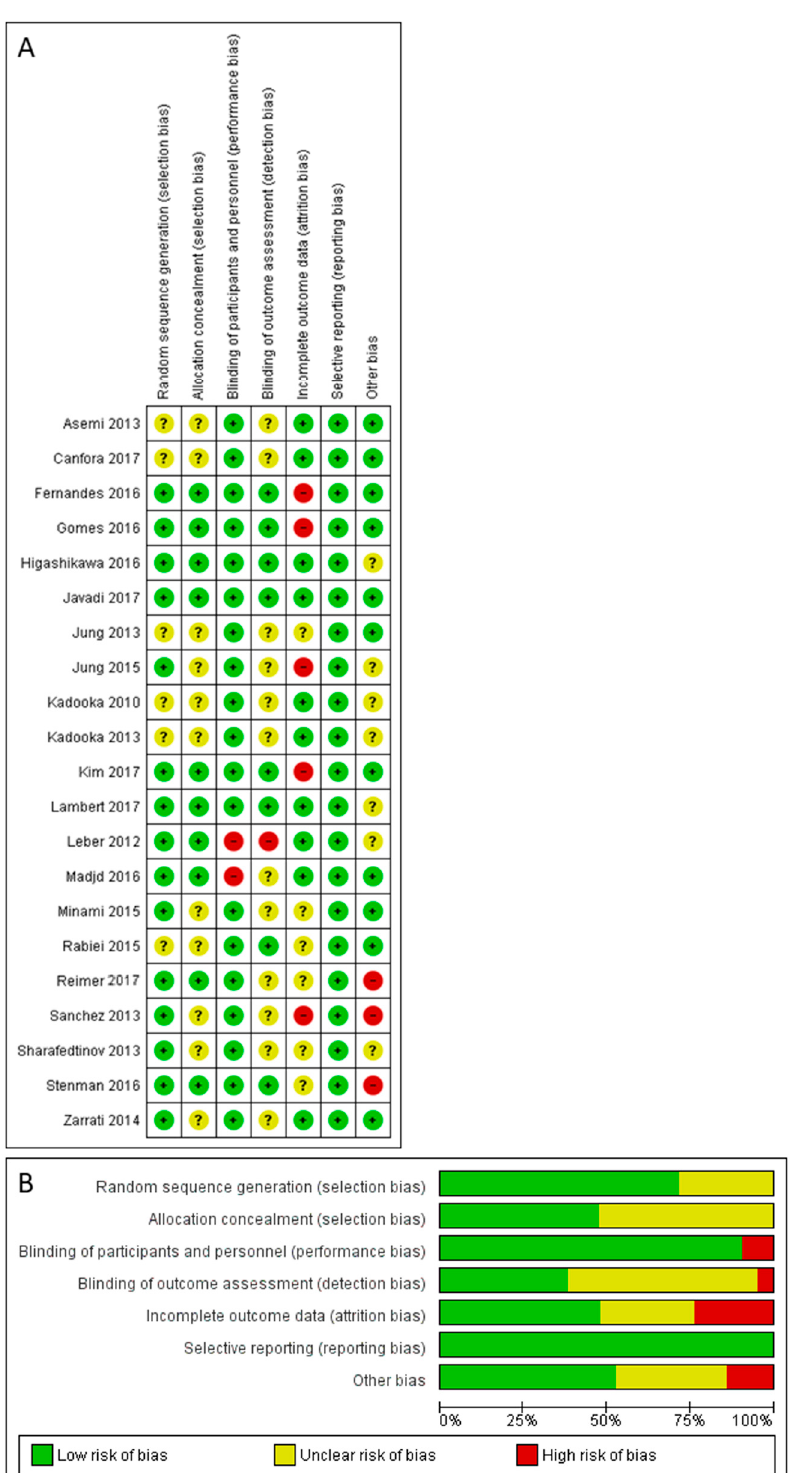
Figure 7. Risk of bias assessment. ( A ) Details of included studies; ( B ) overall summary.